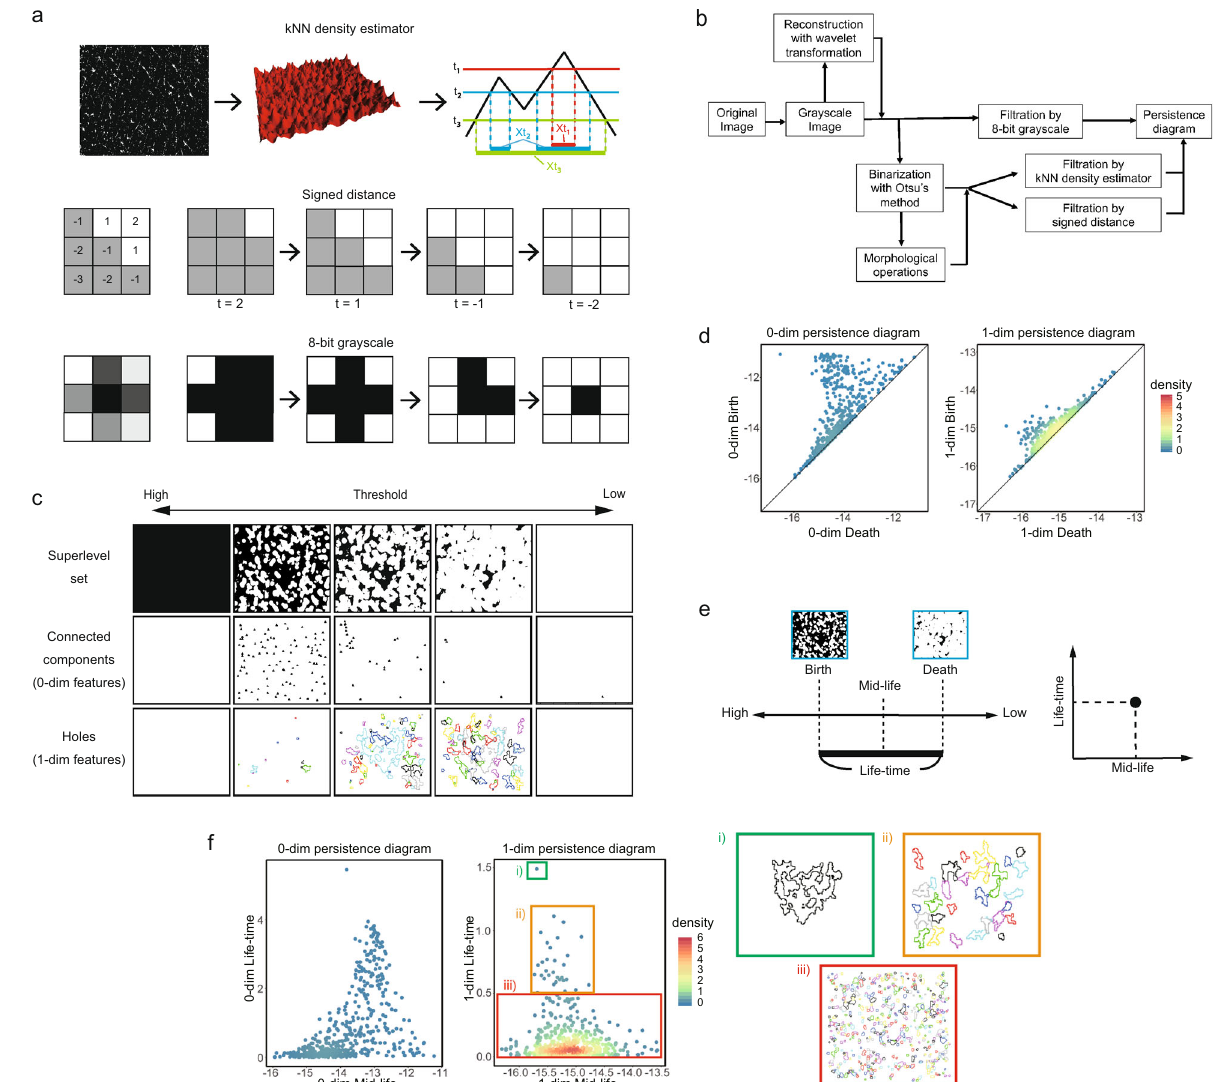
Fig. 1 An illustration of feature extraction using TDA. a Three fi ltration functions are illustrated. In the upper row, the density of white pixels is calculated using the kNN density estimator, and elevated regions in the 3D map represent a higher density. As the threshold decreases from t 1 to t 3 , the superlevel set (the domain above the threshold) grows from Xt 1 to Xt 3 . In the middle and lower rows, the signed distance and the 8-bit grayscale are, respectively, used as fi ltration functions. As the threshold decreases, the superlevel set (white region) expands. b The fl owchart of our method. An original image is transformed into a grayscale image. For the kNN density estimator or signed distance as the fi ltration function, the image is binarized with Otsu ’ s method. Wavelet transformation and morphological operations can be applied. Following TDA, the persistence diagram is obtained. c A schematic diagram of thresholds and superlevel sets. In the upper row, as the threshold decreases, the superlevel set (white region) grows larger. The middle row shows the birthplace of connected components (0-dim topological features), and the lower row shows the holes (1-dim topological features) in the corresponding superlevel set. d The information on the detected topological features of each image is summarized in two diagrams called the persistence diagrams. The axes represent the log-scale thresholds where the feature appears ( “ birth ” ) and disappears ( “ death ” ). The 0-dim persistence diagram represents information of the connected components, and the 1-dim persistence diagram represents that of holes. The color scale represents the density of points in the persistence diagram calculated by the function “ kde2d ” of the R package MASS. e For interpretability and handiness, we transform “ birth ” and “ death ” into their mean (mid-life) and their difference (life-time) and plot them. f The persistence diagrams with the axes mid-life and life- time. The color scale represents the density of points in the persistence diagram. The three small panels on the right show the holes in each corresponding domain of the 1-dim persistence diagram. The life-time roughly corresponds to the size of considered pixel to the k th nearest white pixel for a fi xed integer k 26 . The signed distance method assigns the Manhattan distance from the border between black and white areas with a positive Several TDA algorithms have been proposed in terms of thresh- sign to a white pixel and a negative sign to a black pixel 27,28 . The olding methods called fi ltration functions, including the k -nearest 8-bit grayscale value re fl ects the brightness of a pixel ranging from neighbor (kNN) density estimator, the signed distance, and the 8- 0 (black) to 255 (white) 16 . For each threshold value, the superlevel bit grayscale value (Fig. 1a). The kNN density estimator calculates set is de fi ned as the image region where the value of the fi ltration the density of white pixels by measuring the distance from the